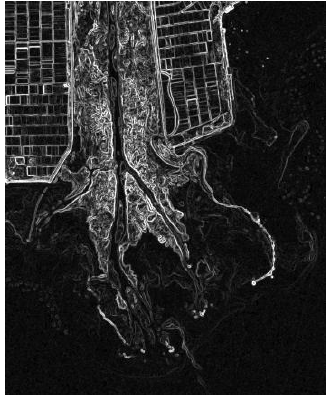
Figure 4d. Axios delta – Sobel